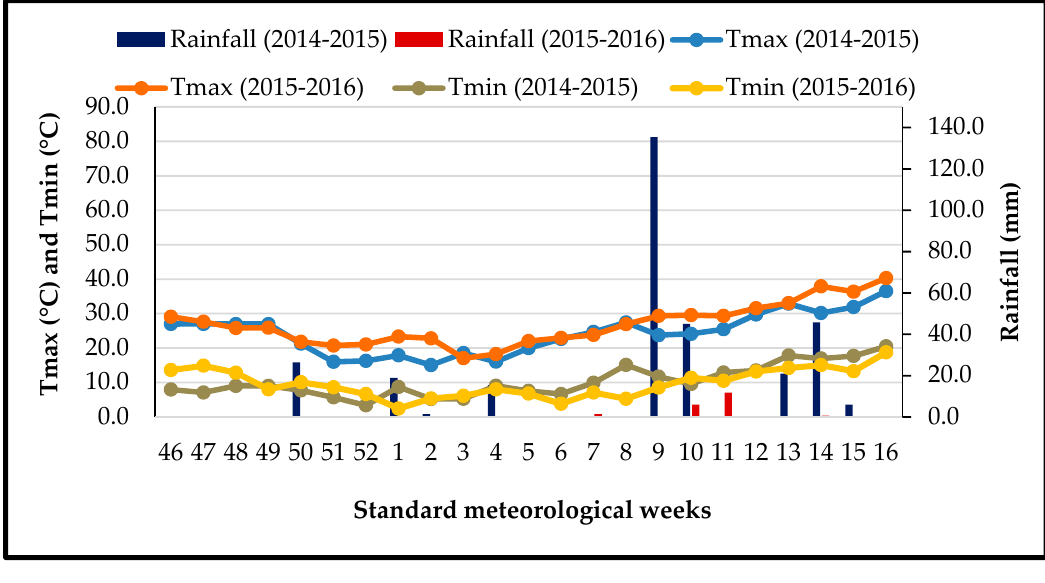
Figure 1. ( a ) Weekly meteorological data for the Kharif seasons maize crop (2014 and 2015); ( b ) Weekly meteorological data for the Rabi seasons wheat crop (2014–2015 and 2015–2016).